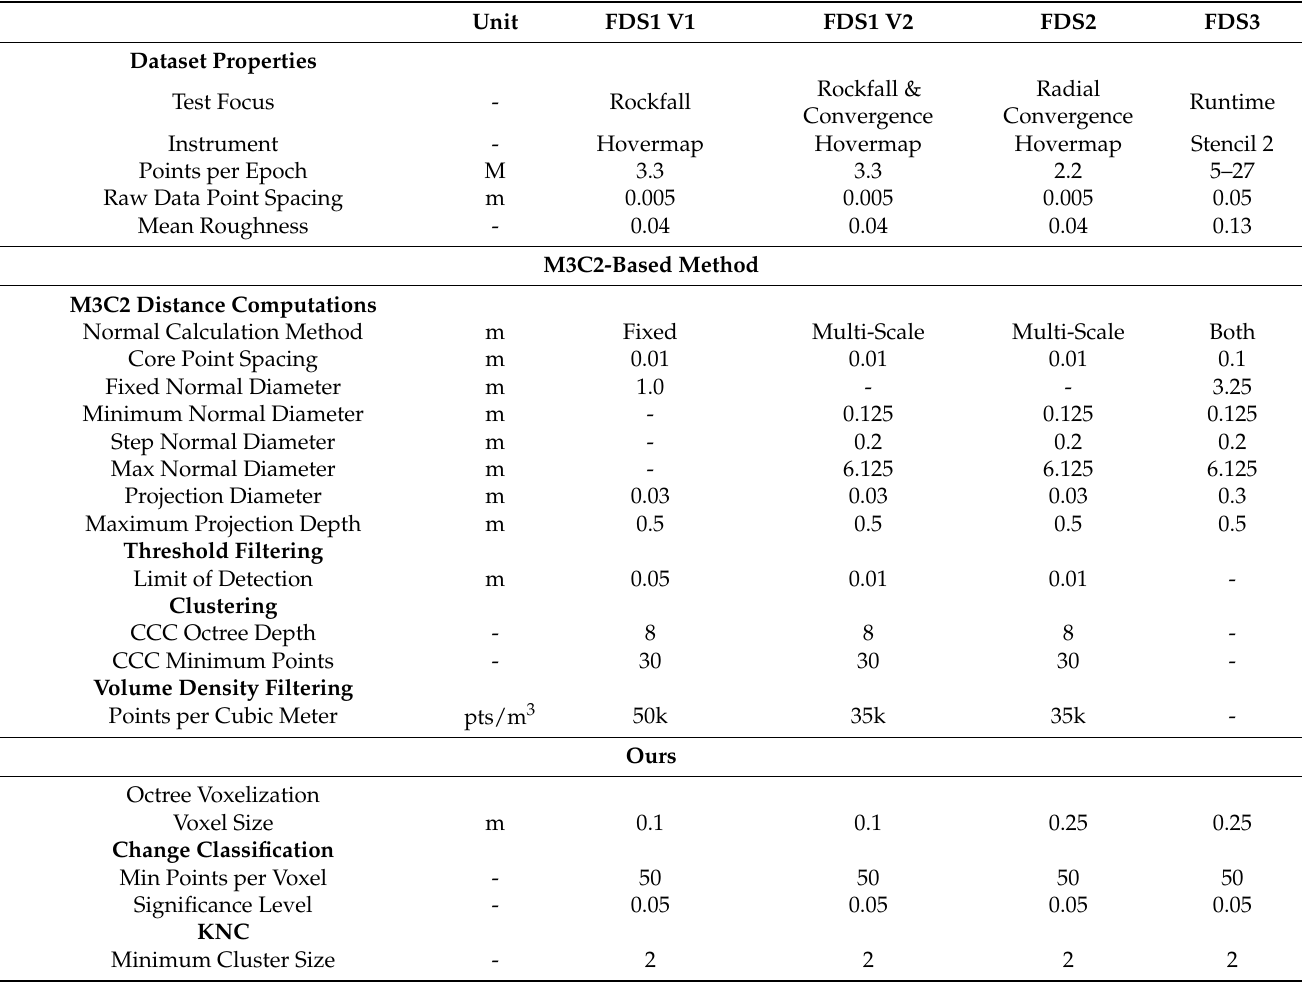
Table A1. Summary of processing parameter by test and dataset for M3C2-based, as well as our own,